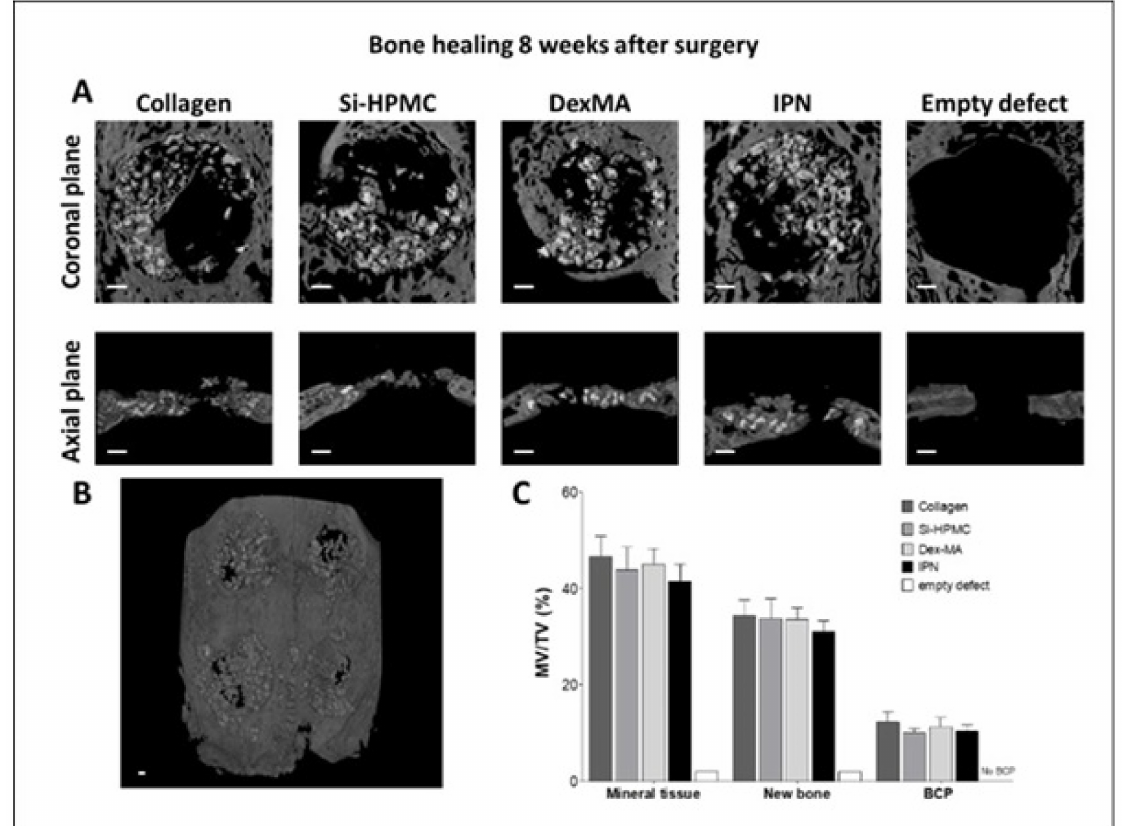
Figure 8. Bone healing evaluation 8 weeks after implantation ( A ) Micro-CT imaging of the calvaria defects with diameters of 8 mm, ( B ) 3D reconstruction of the external view of the calvaria. Clockwise from top left: control collagen membrane, Si-HPMC, IPN, and DexMA. ( C ) Quantification of the percentage of mineral volume versus the total volume (MV/TV) of the total mineral tissue, new bone formation, and biphasic calcium phosphate granules (BCP) in the volume of interest. Error bars represent the standard deviations of the means, collagen n = 6, Si-HPMC n = 5, DexMA n = 6, IPN n = 6, empty defect n = 1. Si-HPMC: silanized hydroxypropyl methylcellulose, DexMA: dextran methacrylate, IPN: interpenetrating polymer network. No statistical difference was found between the groups. (Scale bar: 1